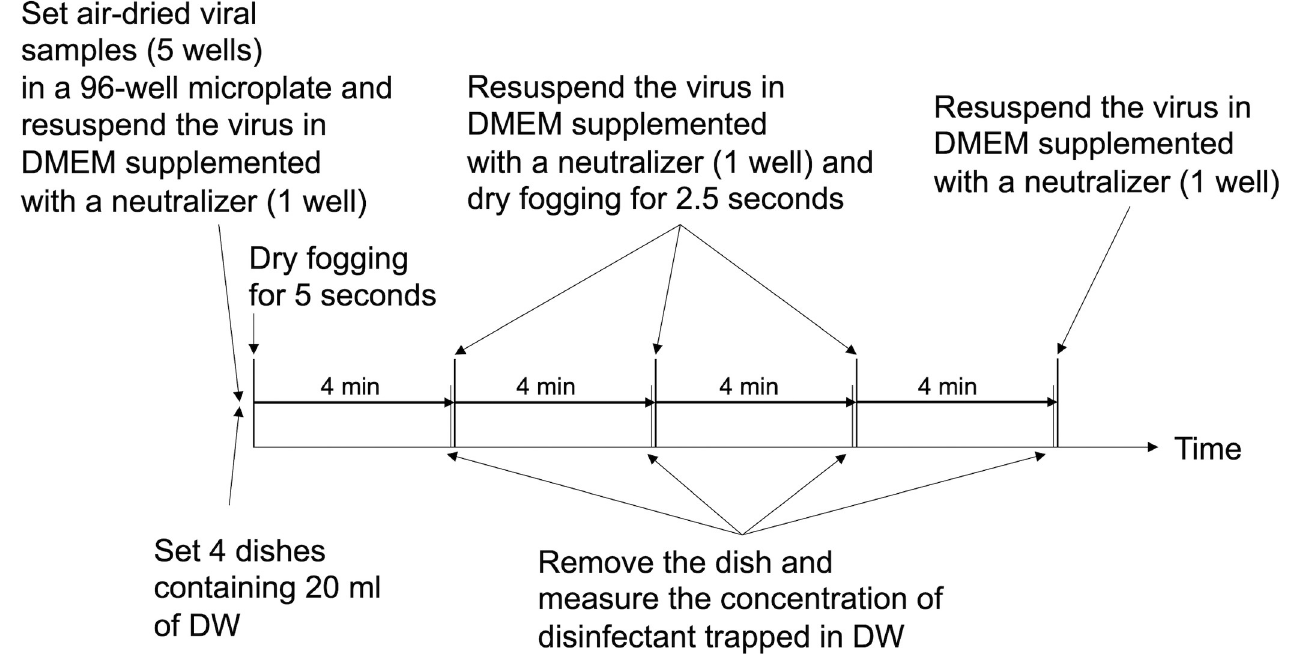
Fig 2. Flow diagram of the virus inactivation experiment. A detailed procedure is described in the Materials and methods.